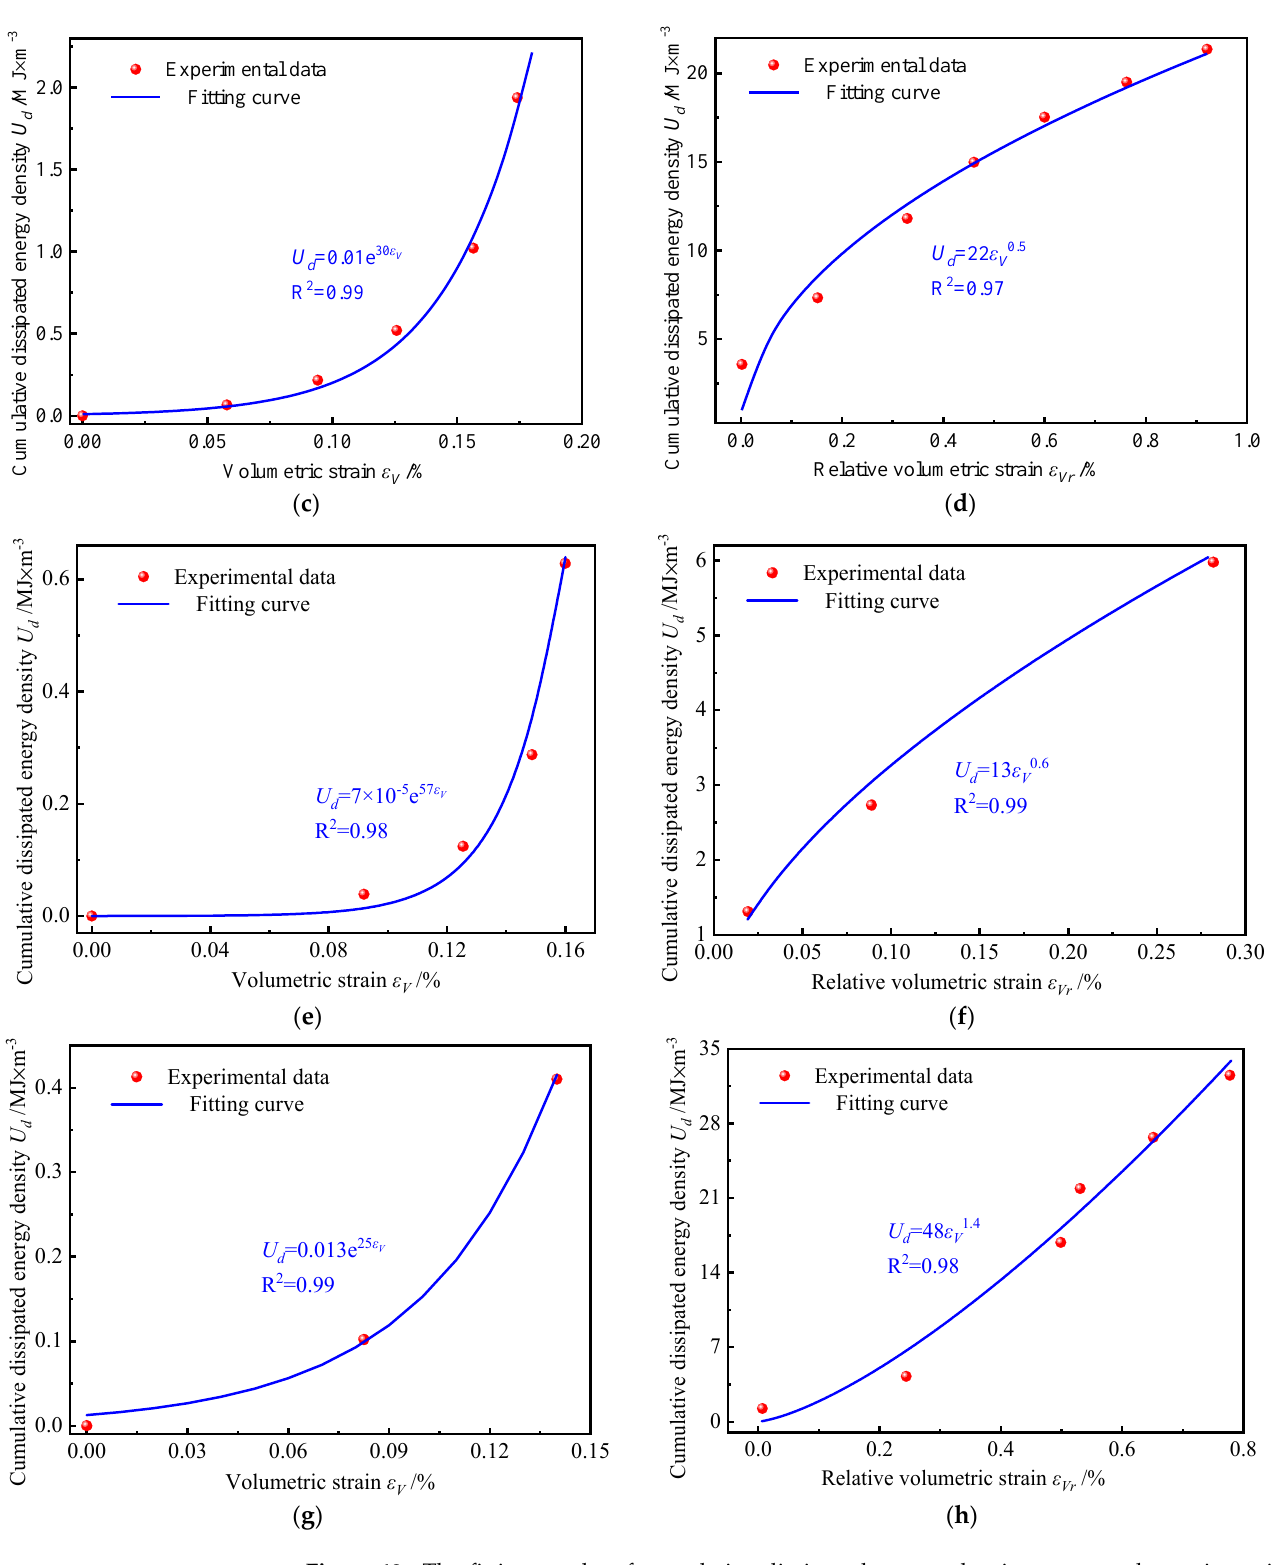
Figure 12. The fitting results of cumulative dissipated energy density versus volumetric strain. ( a )